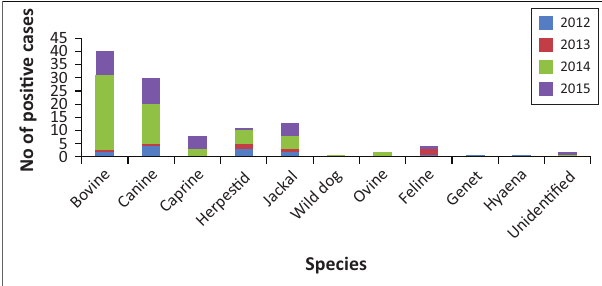
FIGURE 5: Numbers of positive rabies cases in various species from 2012 to 2015 from the North West